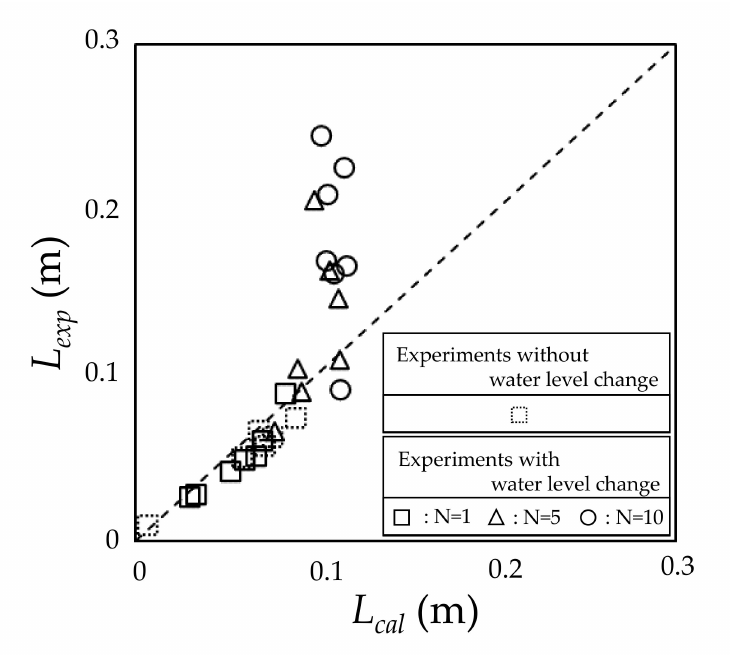
Figure 19. Relationship between calculated L cal and experimental values L exp : Experiments without water level change are Case 1, 3, 4, 8, 10 and 12, Experiments with water level change are Case 2, 5, 6, 7, 9, 11 and